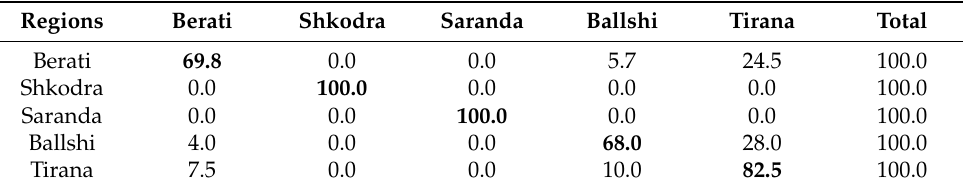
Table 2. Percentage of initial classifications that were correct, shown by region.